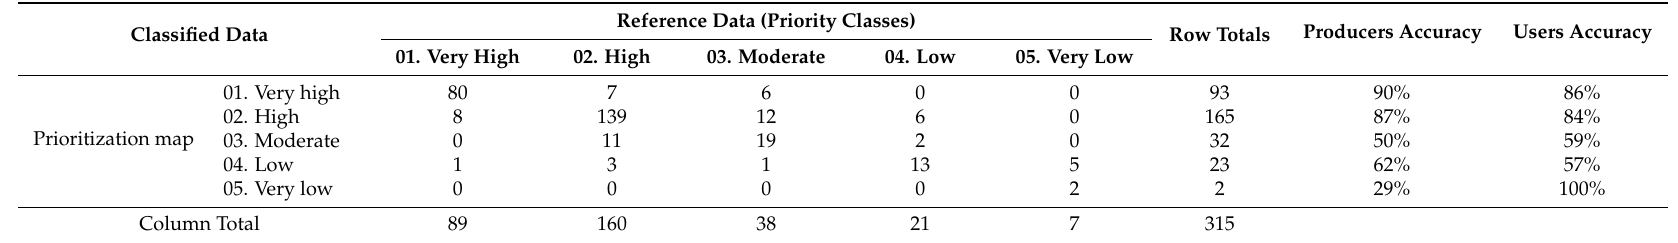
Table 6. Accuracy assessment of prioritization map using field-plot data using error matrix